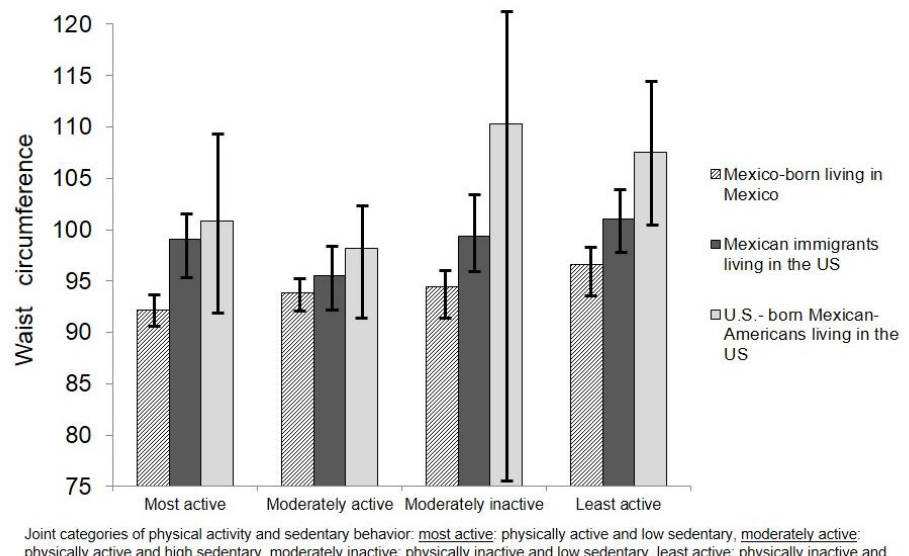
Figure 2. Mean of waist circumference among Mexican-born living in Mexico and Mexican immigrants and Mexican-Americans living in the US according to joint categories of physical activity and sedentary behavior.